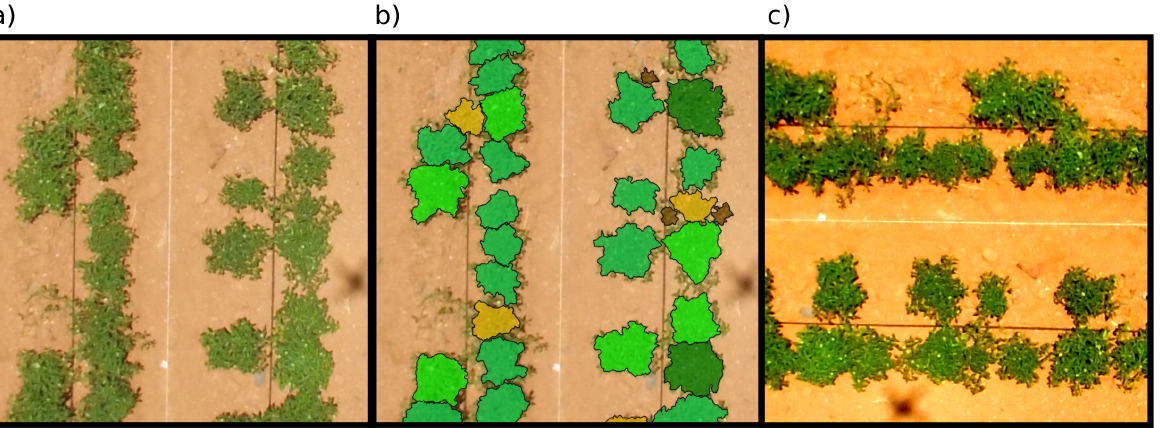
Figure 4. Training and validation datasets. ( a ) Original image of a 512 × 512 px section of the crop taken with a UAV. ( b ) Georeferenced instance segmentation masks elaborated from on field data. ( c ) Example of augmented data generated by applying randomly chosen transformations to the